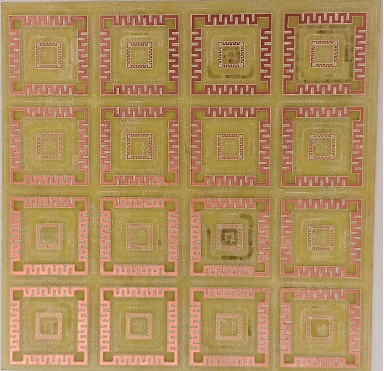
Figure 11. FSS scaled prototype. Table 2. Unit cell dimensions of the FSS scaled prototype.